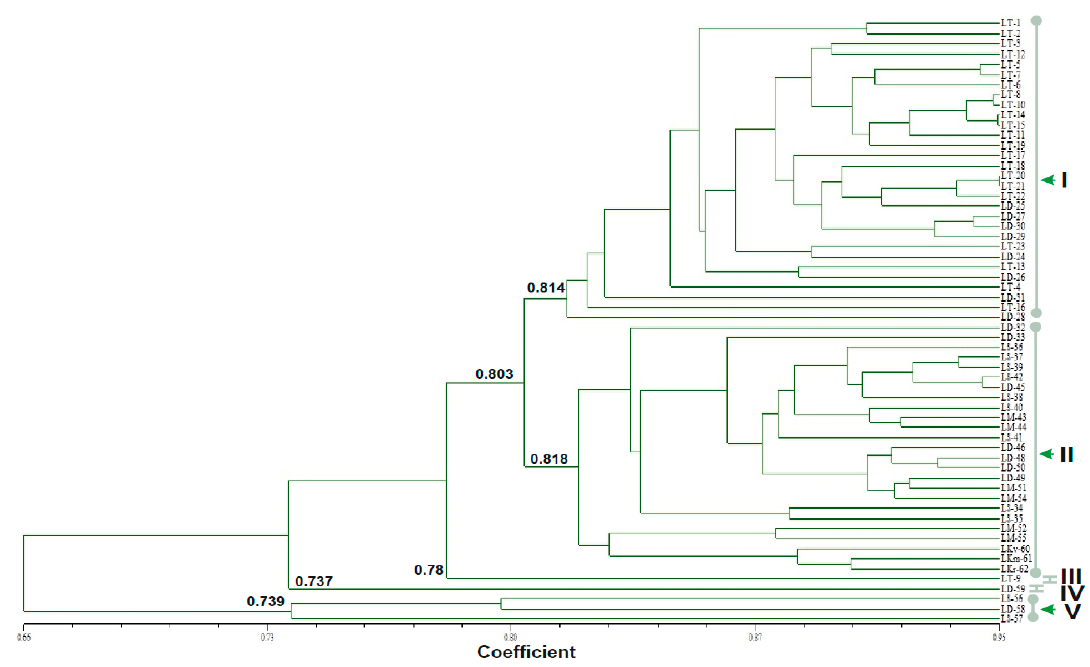
Figure 3. Phenogram generated for 60 Citrus aurantifolia (Acid lime) cultivars (please refer to Table 1 for sample details) by unweighted pair group method of arithmetic averages (UPGMA) cluster analysis, using the Dice similarity coefficient computed from 234 ISSR loci generated by 21 primers. The clusters are labeled as I, II, III, IV, and V.